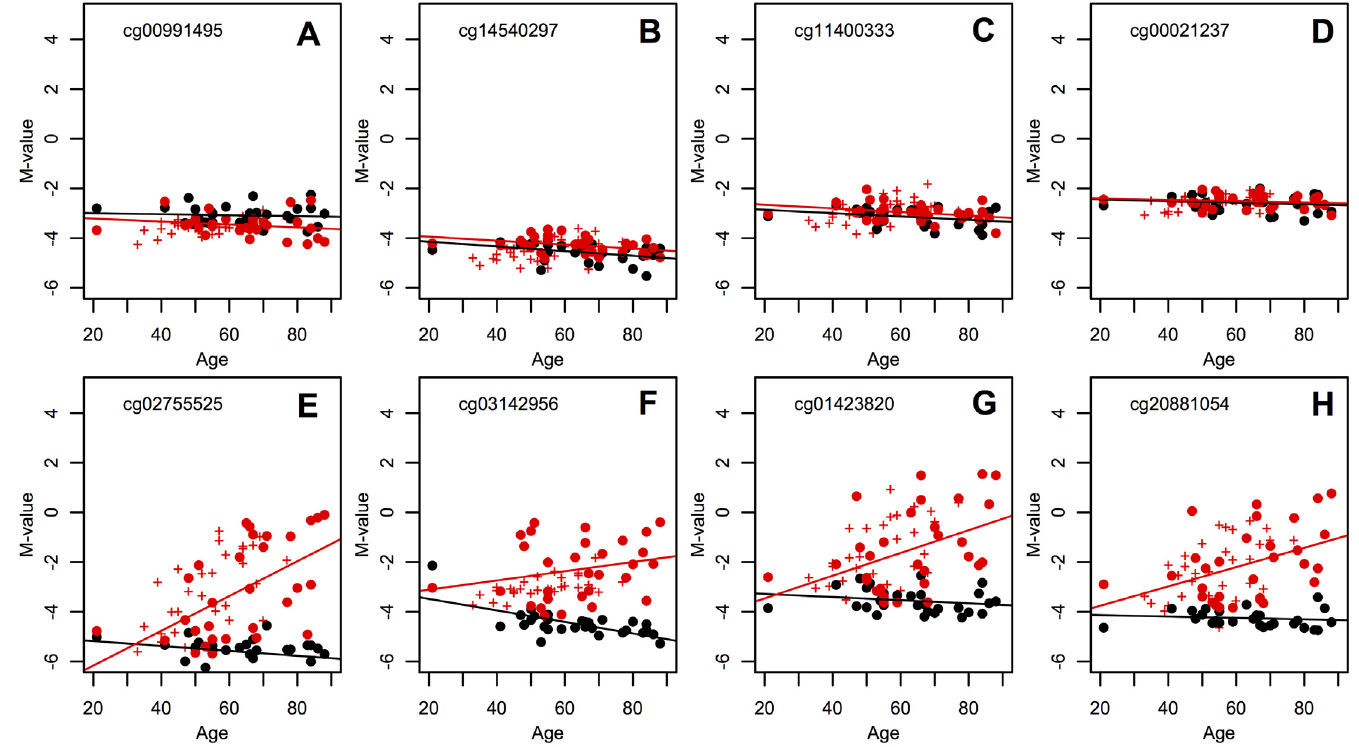
Fig 3. Cross-sectional data and BE clock CpGs. Cross-sectional patient data D2, in which matched squamous (SQ) M-values (black points) and BE M- values (red points) are plotted at corresponding age of biopsy. (A-D) Top row shows 4 of 400 total hypomethylated CpG sites, in which the regression rates of SQ and BE across individuals is not significantly different (p-value = 0.5). In contrast, (E-H) the bottom row shows 4 of the 67 BE clock CpGs with highest p-values for significant individual BE drift from the longitudinal data set D1. The BE clock CpGs are chosen to have significant BE drift differing from SQ drift (p-value = 0.05 with ANCOVA) and large heterogeneity around the population average due to heterogeneous BE onset ages (see Material and Methods). BE data for the longitudinal patients in data set D1 (designated by ‘ + ’ signs, as in Fig 1) show consistency between the two data sets. Corresponding regression lines for cross-sectional data D2 are also